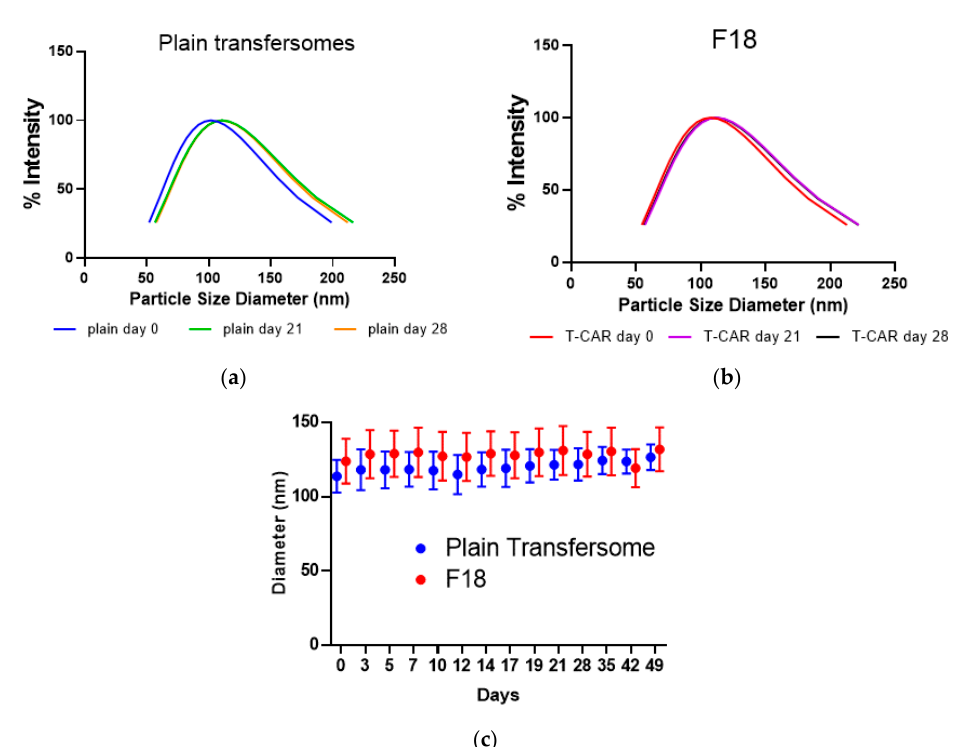
Figure 1. Transfersome size distribution and stability analysis. Representative transfersome size distribution for the plain transfersome ( a ) and the selected transfersome containing carvedilol (F18) ( b ) after storage of different days at 4 °C. ( c ) The size in diameter of the plain transfersomes or F18 as a function of time while maintained at 4 °C (F18 n = 6; plain transfersomes n = 3). Data expressed as mean ± SD.